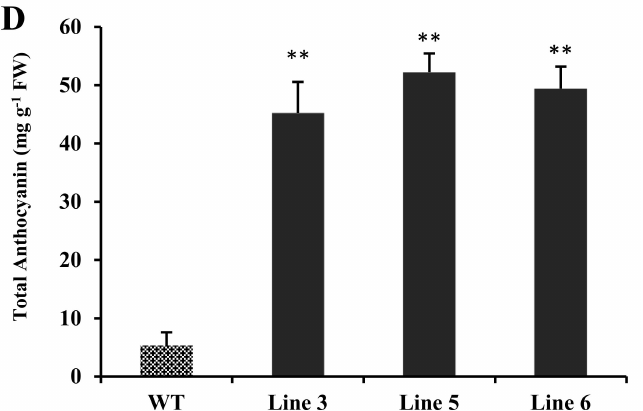
Figure 6. Phylogenetic analysis and overexpression of sugarcane MYB(t) gene result in Arabidopsis thaliana . ( A ) Phylogenetic analysis of protein sequence of MYB(t) gene with homolo- gous genes from other plants species. ( B ) Protein sequence alignment of MYB(t) with homologous MYB genes from other plant species. ( C ) Three MYB(t) transgenic lines showing pinkish brown color in the hypocotyls, whereas the wild type hypocotyl did not show any color (the photographs were taken at seedling stage seven day old Arabidopsis plants). ( D ) Graph representing total anthocyanins contents in the hypocotyls of transgenic and wild type Arabidopsis seedlings. Each value is the mean of three biological replicates. Student’s t -test was used to compare total anthocyanin contents in transgenic and wild type Arabidopsis at ** p <